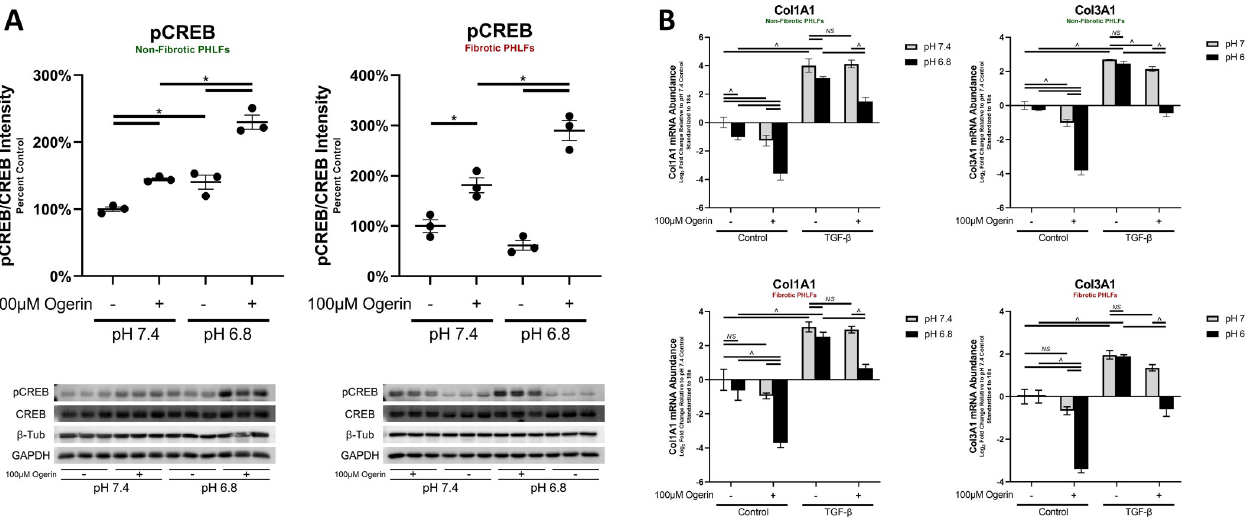
Fig 7. Ogerin’s activation G α s signaling and inhibition of basal and TGF- β induced collagen gene transcription is potentiated by acidic pH. A: Primary human lung fibroblasts derived from non-fibrotic or IPF patients were treated +/- 100 μ M Ogerin for 40 Minutes in pH adjusted PBS. Whole cell lysates were analyzed for phosphorylated CREB expression via Western Blot. Phosphorylated CREB intensity standardized to total CREB expressed as a percent of control. n = 3 per donor per treatment group, dots representative of technical replicates with SEM. B: Primary human lung fibroblasts derived from non-fibrotic subjects or those with IPF were co-treated with 1ng/mL TGF- β and/or 100 μ M Ogerin for 48 hours in pH adjusted, CO 2 Independent media. Col1A1 and Col3A1 mRNA transcript levels were analyzed via qRT-PCR. Transcript abundance was standardized to 18s rRNA by the ΔΔ Ct method and expressed as percent TGF- β induced. ^ = p < 0.05, NS = Not Significant by Two -Way ANOVA with Multiple Comparisons of cells means regardless of rows and columns. � = p < 0.05, by One-Way ANOVA with Tukey’s Post-Hoc Test for Multiple Comparisons.